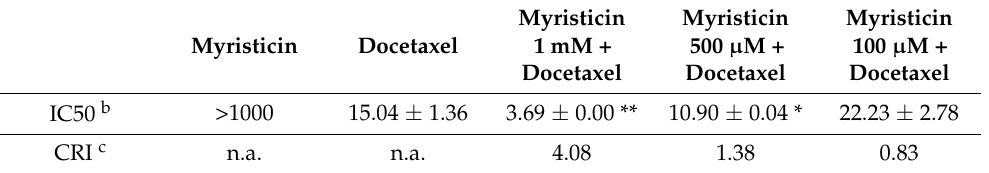
Table 2. Cytotoxic activity expressed as IC50 (μM) of myristicin and docetaxel and their association in the NCI/ADR-RES a lineage after 48 h of exposure.